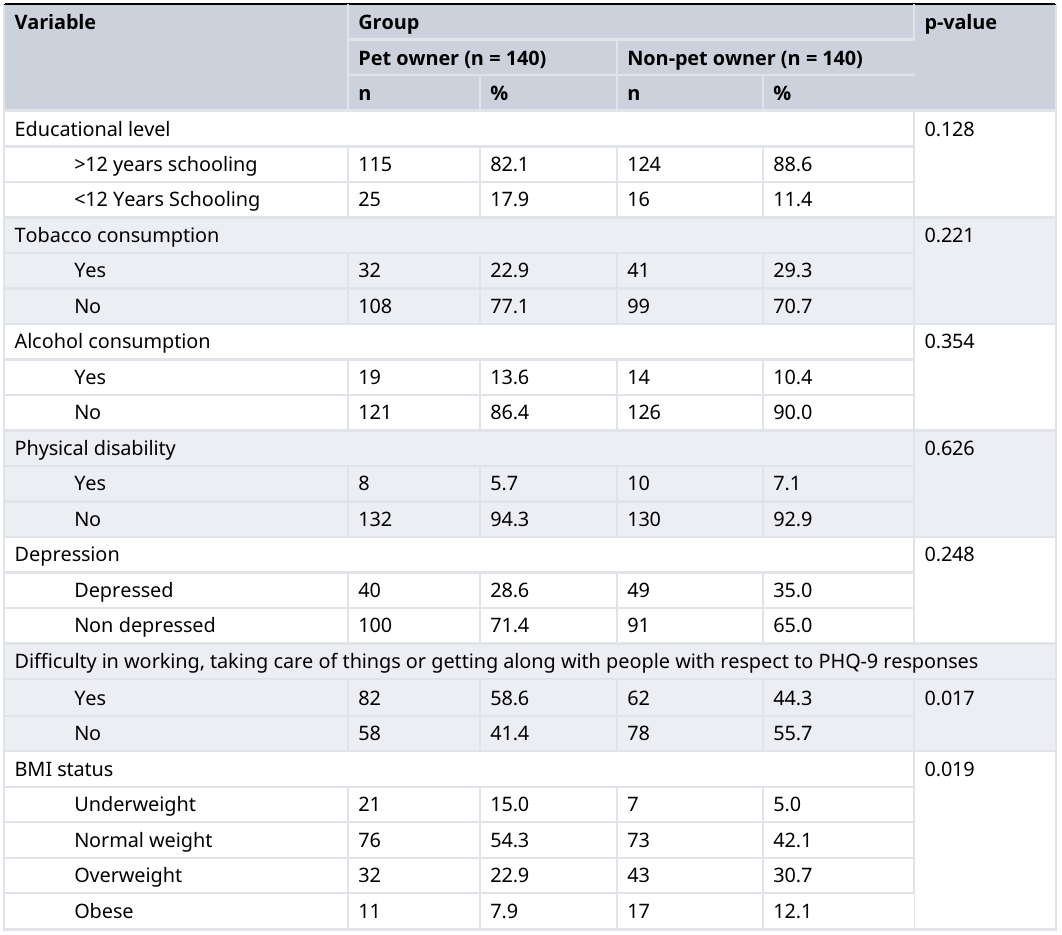
six were statistically significant: gender (AOR: 3.38, CI: 1.50 – 7.62), marital status (AOR: 2.10, CI: 1.05 – 4.16), tobacco use (AOR: 2.72, CI: 1.04 – 7.09), physical disability (AOR: 5.27, CI: 1.50 – 18.53) and difficulty in working, taking care of things or getting along with people with respect to PHQ-9 responses (AOR: 5.94, CI: 3.16 – 11.16). Although not significant in this analysis, pet owners were 41% (AOR: 0.59, CI: 0.31 – 1.14) less depressed than the control